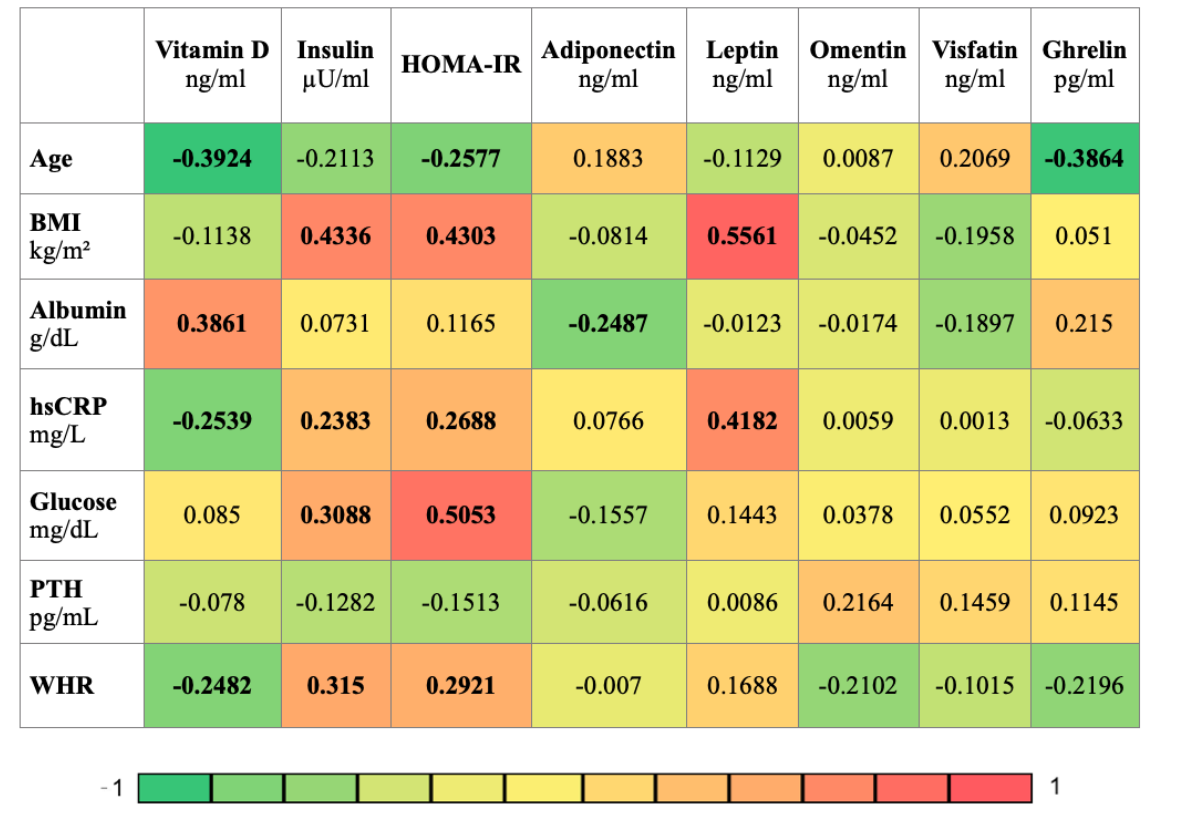
Figure 2. Heatmap displaying the r values obtained from Spearman correlation analysis performed among clinical variables; p -values < 0.05 were considered to indicate statistical significance and are marked in bold. BMI, body mass index; hs-CRP, high sensitivity C-reactive protein; PTH, parathyroid hormone; WHR, waist-hip ratio; HOMA-IR, Homeostatic Model Assessment—Insulin Re- sistance.